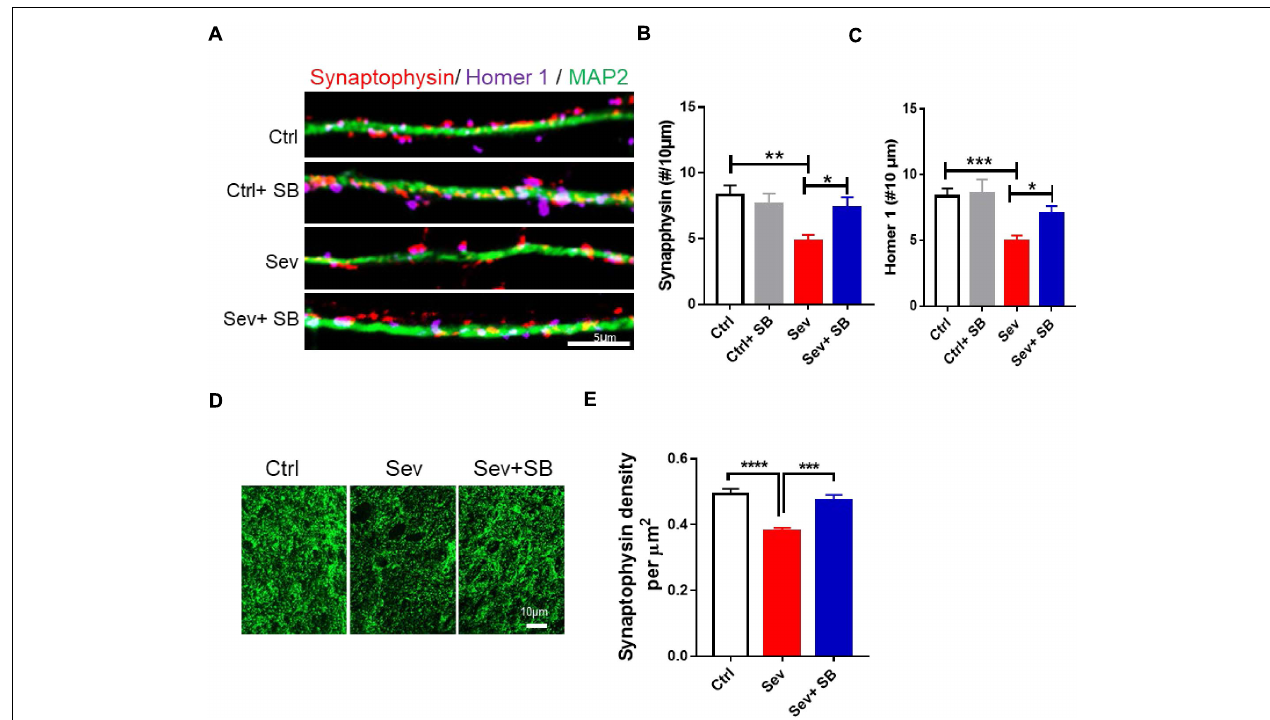
FIGURE 2 | Pretreatment with TRPV1 antagonist SB 366791 significantly suppressed synaptic density loss induced by sevoflurane exposure. (A) Fluorescent images of synaptophysin and homer 1 puncta density in hippocampal neurons in the Ctrl and Sev cultures treated with TRPV1 antagonist SB 366791 (10 µ M). (B,C) Quantitative analysis of synaptophysin (B) and homer 1 (C) puncta density in the Ctrl and Sev cultures [3 cultures per group, one-way ANOVA, synaptophysin: F ( 3 , 56 ) = 5.0, p = 0.0041, homer 1: F ( 3 , 58 ) = 6.9, p < 0.001]. (D,E) Representative fluorescent images (D) and quantitative analysis (E) of synaptophysin puncta density in the CA1 area of the with or without SB 366791(500 µ g/kg) treatment mice [7 mice per group, F ( 2 , 18 ) = 18.2, p < 0.0001]. Data are presented as the mean ± SEM. ANOVA followed by Bonferroni post hoc test. * p < 0.05; ** p < 0.01; *** p < 0.001; **** p < 0.0001. Ctrl, control; Sev, sevoflurane; SB, SB